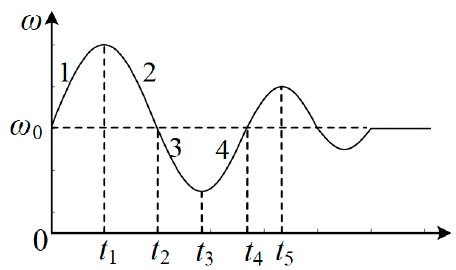
Figure 6. Grid frequency response curve.